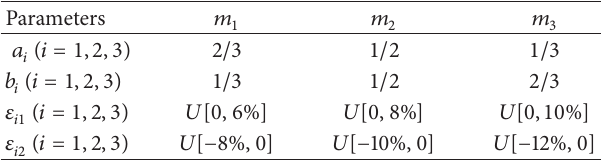
Algorithm 10 (birandom simulation for (4)).